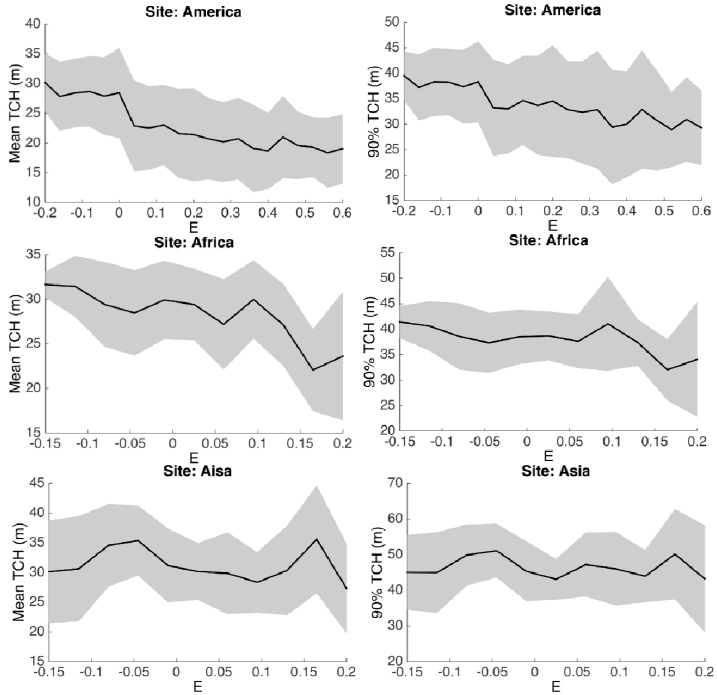
Figure 5. Tree height (TCH m and TCH 90 ) variations with E factor. The E factor is one of the most significant climate variables in the spatial regression results of TCH 90 across all continents. The height metrics are binned up to 20 groups along the E factor axis to get the mean and standard deviation.